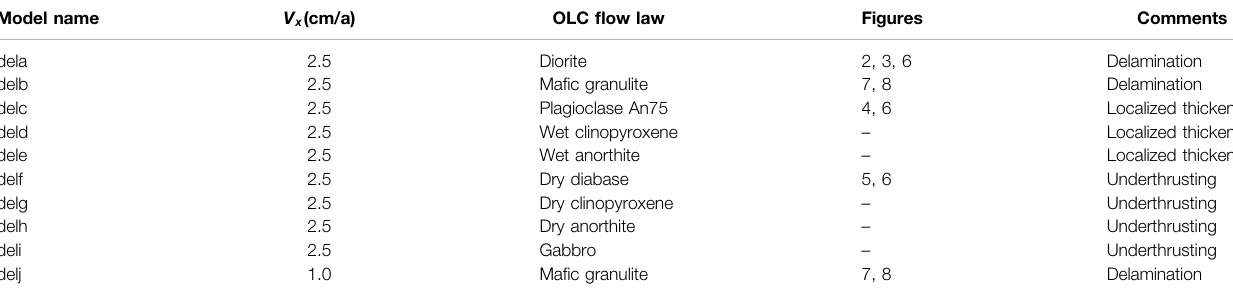
TABLE 2 | Parameters and Results of Conducted Experiments a